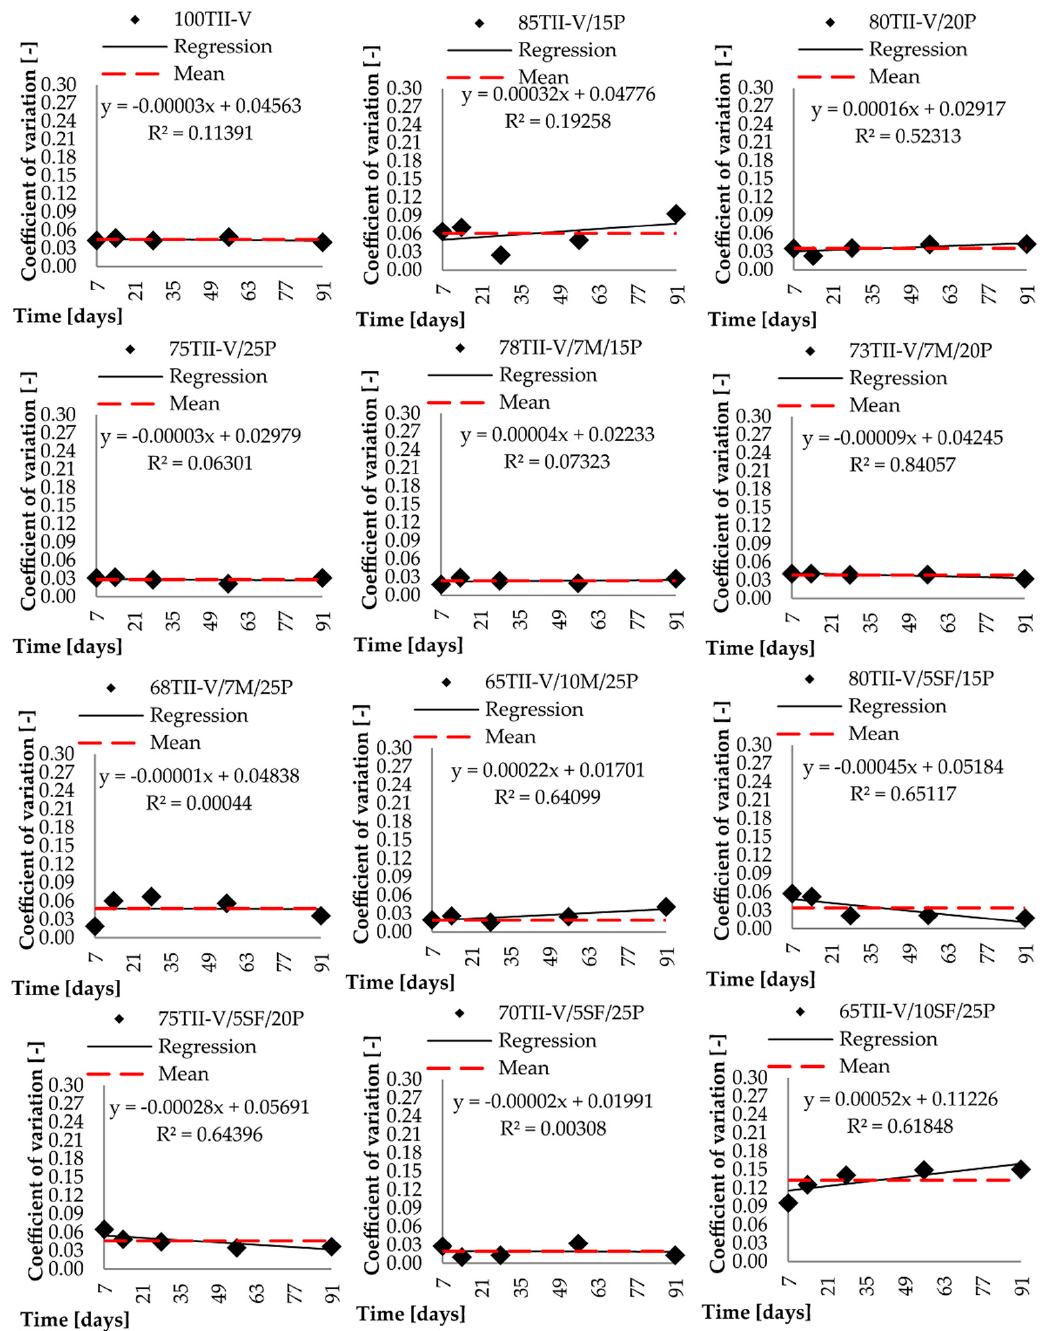
Figure 7. Comparison of experimental data with mean and linear regression approximations of variation coefficients for mixtures groups with pumice, metakaolin, and silica fume.